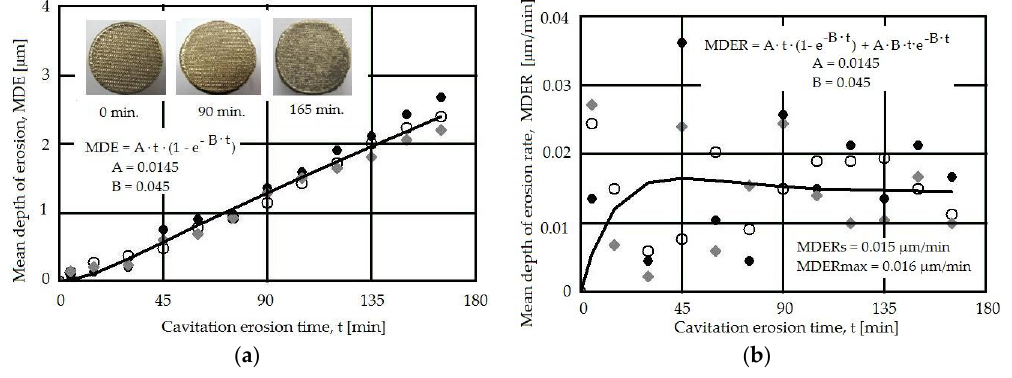
Figure 8. Cavitation erosion curves for the 2200 W laser pulse power. ( a ) Mean depth of erosion (MDE)( t ); ( b ) Mean depth of erosion rate (MDER)( t ).